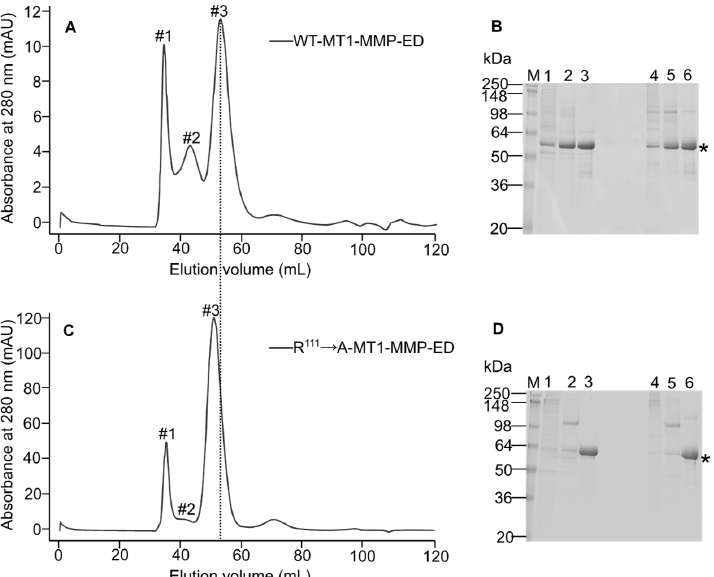
Figure 3. MT1 ‐ MMP furin cleavage site mutant (R 111 → A) is monomeric, while the WT is multimeric. Analysis of the oligomeric structures of WT and mutant MT1 ‐ MMP by size ‐ exclusion chromatography and SDS ‐ PAGE. ( A ) Gel filtration elution profiles of WT ‐ MT1 ‐ MMP ectodomain. After purification by affinity chromatography, the enzyme solution was concentrated at 1 mg/mL and applied to a sephacryl 200 gel filtration column. On the chromatogram is marked with #1 for the first peak (the highest molecular weight—oligomer), #2 for the second peak—dimer, and #3 for the third peak—monomer. ( B ) Coomassie brilliant blue ‐ stained SDS ‐ PAGE characterization of the peaks content from gel filtration column of the WT ‐ MT1 ‐ MMP ‐ ED. M ‐ molecular weight marker; lane 1: WT ‐ MT1 ‐ MMP ‐ ED #1; lane 2: WT ‐ MT1 ‐ MMP ‐ ED #2; lane 3: WT ‐ MT1 ‐ MMP ‐ ED #3; lanes 1 to 3 under reducing conditions; lanes 4 to 6 in the same order as for lanes 1 to 3, but under non ‐ reducing conditions. ( C ) Gel filtration elution profile of R 111 → A ‐ MT1 ‐ MMP ectodomain. The same procedure and labeling as in ( A ). ( D ) Coomassie brilliant blue ‐ stained SDS ‐ PAGE analysis of R 111 → A ‐ MT1 ‐ MMP ‐ ED from gel filtration. M: molecular weight marker; lane 1: R 111 → A ‐ MT1 ‐ MMP ‐ ED #1; lane